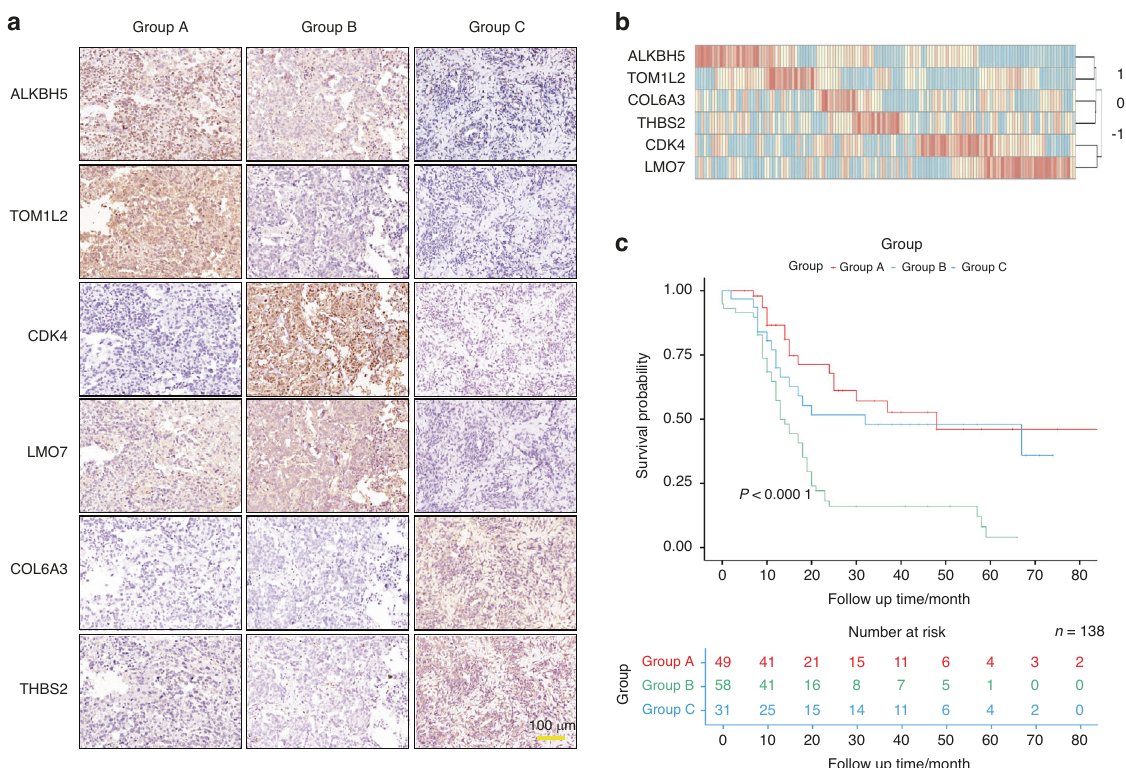
Fig. 5 Group classi fi cation of OS samples based on IHC staining. a IHC staining of ALKBH5, TOM1L2, CDK4, LMO7, COL6A3, and THBS2 in three OS samples from each group (No. 13, No. 68, and No. 79 of OS samples). b Statistical analysis of expression of six gene markers in each OS sample. c Kaplan – Meier curves of overall survival for the three groups of OS